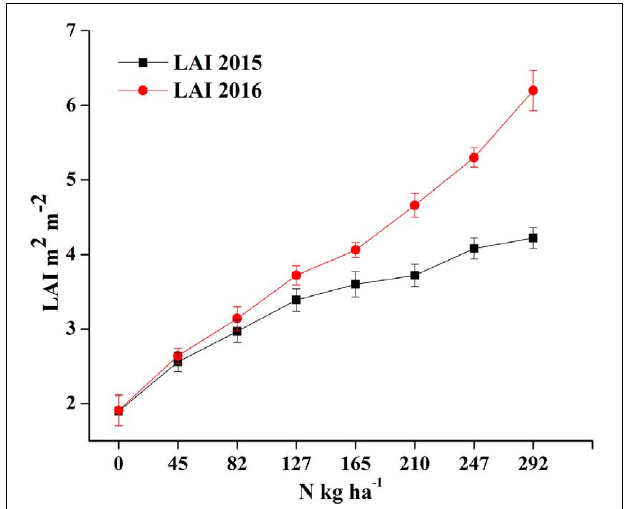
FIGURE 6 | Changes in LAI over two growing seasons in rice under varied N levels 0, 45, 83, 128, 165, 210, 248, and 293 kg N ha − 1 in 2015 (A) and 2016 (B)